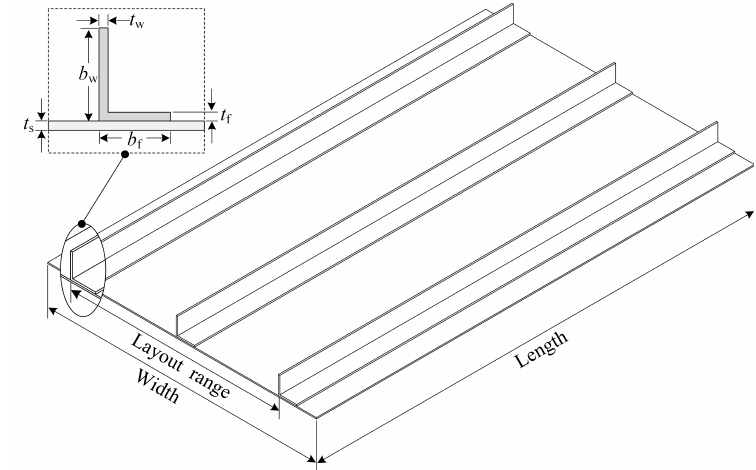
Figure 1. Schematic of metal stiffened plate.